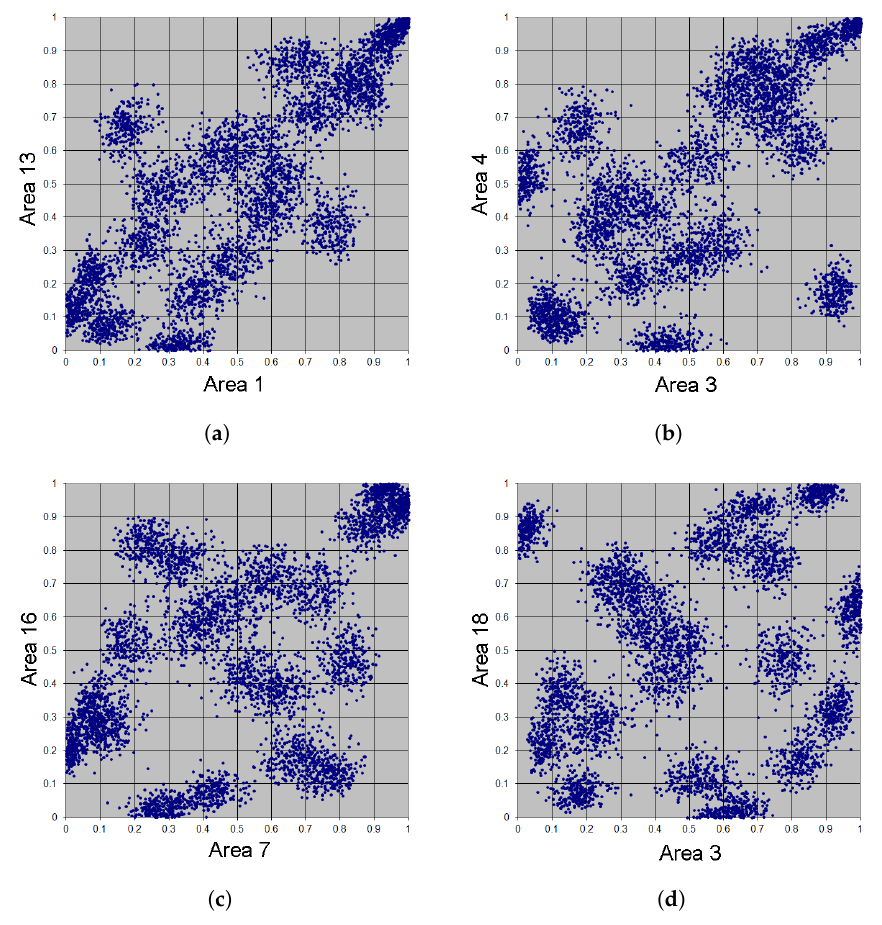
100. ( a ) Area 1 vs. “